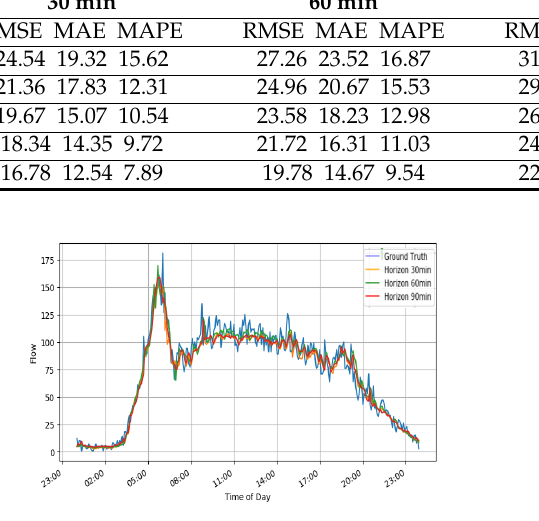
Figure 10. Traffic flow in different horizons.